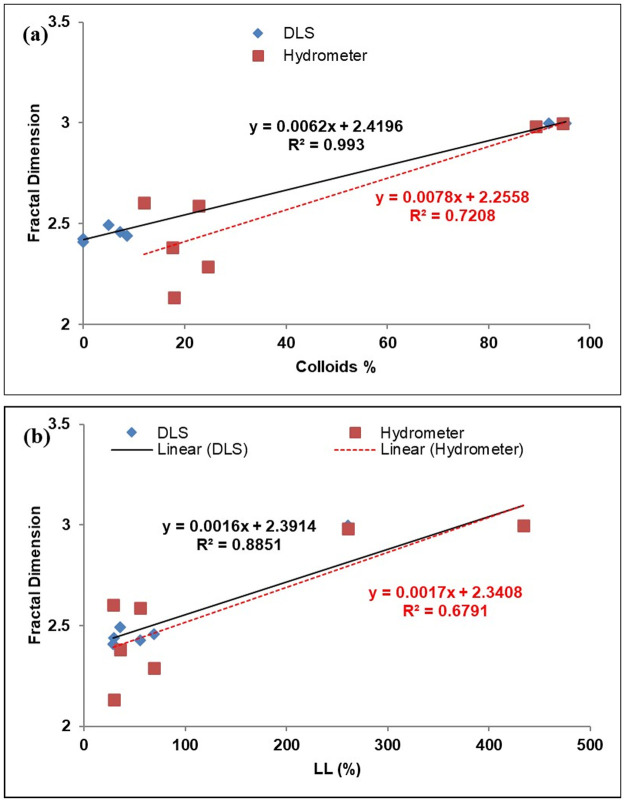
Fractal dimension correlations with (a) Colloids % & (b) LL %.